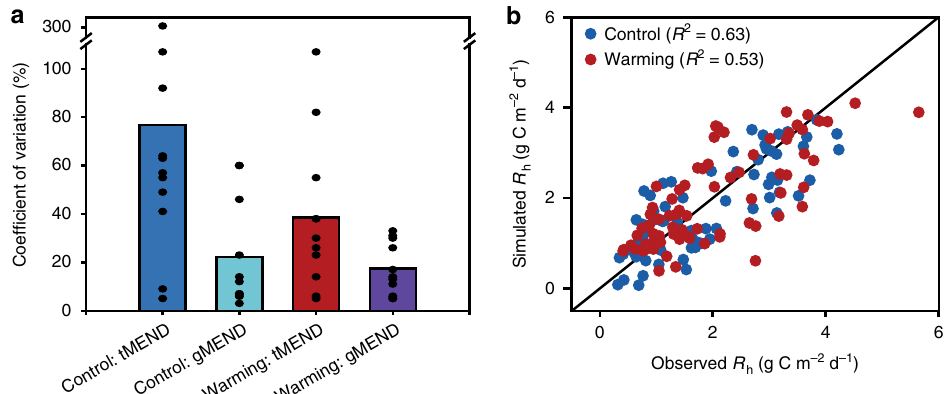
Fig. 3 Model parameter uncertainty and modeling performance. a The MEND model parameter uncertainty quanti fi ed by the Coef fi cient of Variation (CV). The bars show the mean CV values of the 11 parameters (See Supplementary Fig. 12 and Supplementary Table 8 for detailed description). The dots along each bar show the CV for each parameter. The tMEND refers to the traditional MEND model parameterization without gene abundances data. The gMEND denotes the improved MEND parameterization with gene abundances. b Comparison between gMEND-simulated and observed heterotrophic respiration ( R h ) under control and warming ( R 2 denotes the coef fi cient of determination).